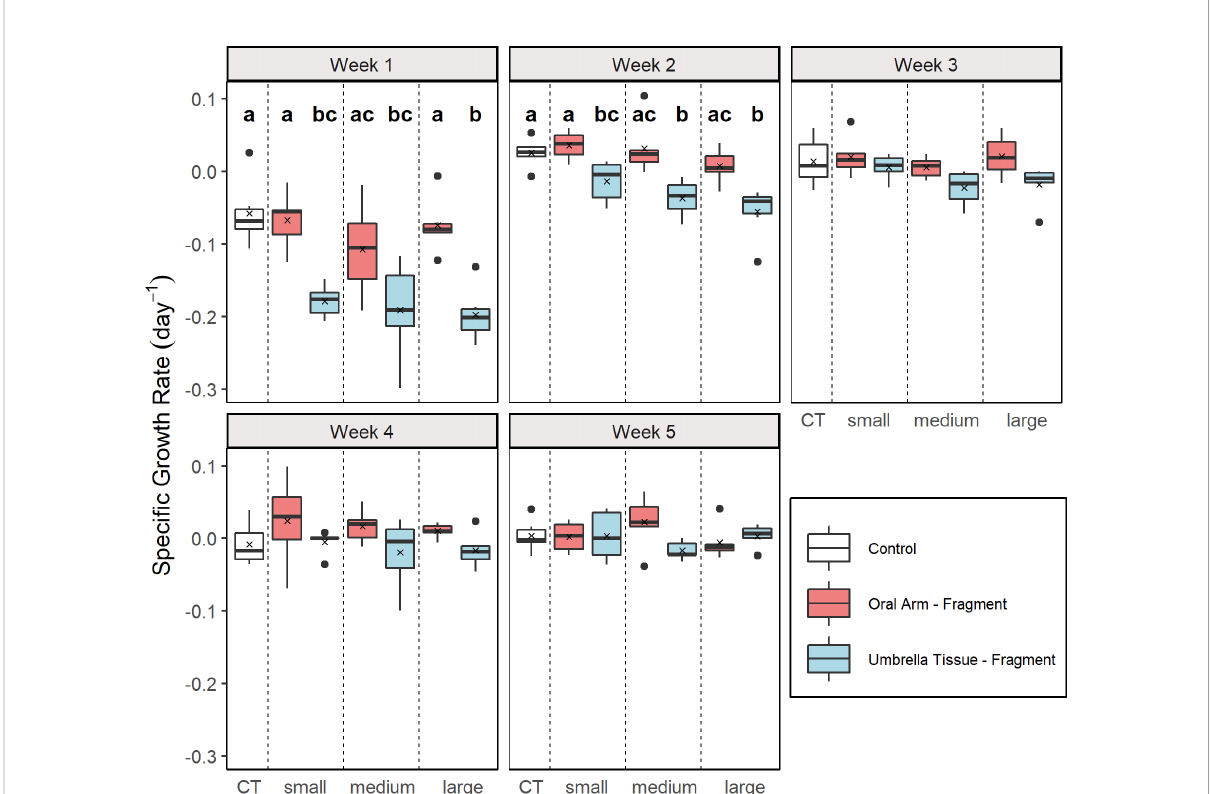
FIGURE 3 Weekly speci fi c growth rate (SGR) for the different groups (n = 5 for the UT-medium and the UT-large group in week 5; n = 6 for the other groups). Control (CT), oral arm (OA) - and umbrella tissue (UT) - fragments are indicated by white, red and blue color, respectively. The data is presented as boxplots including the median (black line), the mean value (black cross) and outliers (black dots). Different letters indicate signi fi cant differences between the groups in the respective week according to a multiple comparison Wilcoxon rank sum test with adjusted p- values by the Benjamin and Hochberg method (p<